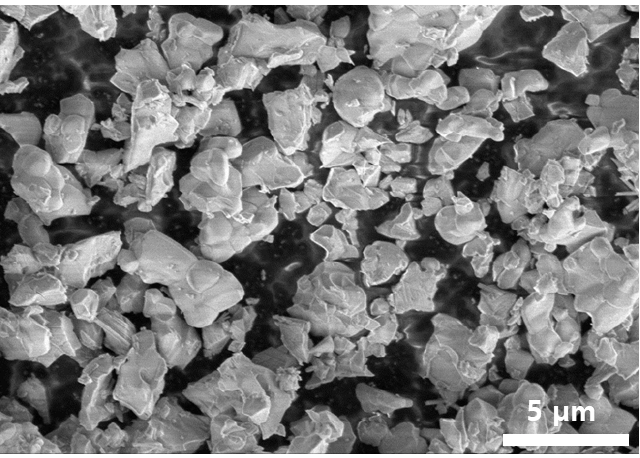
Figure 1. FE-SEM image of commercial Y 5 O 4 F 7 powder.